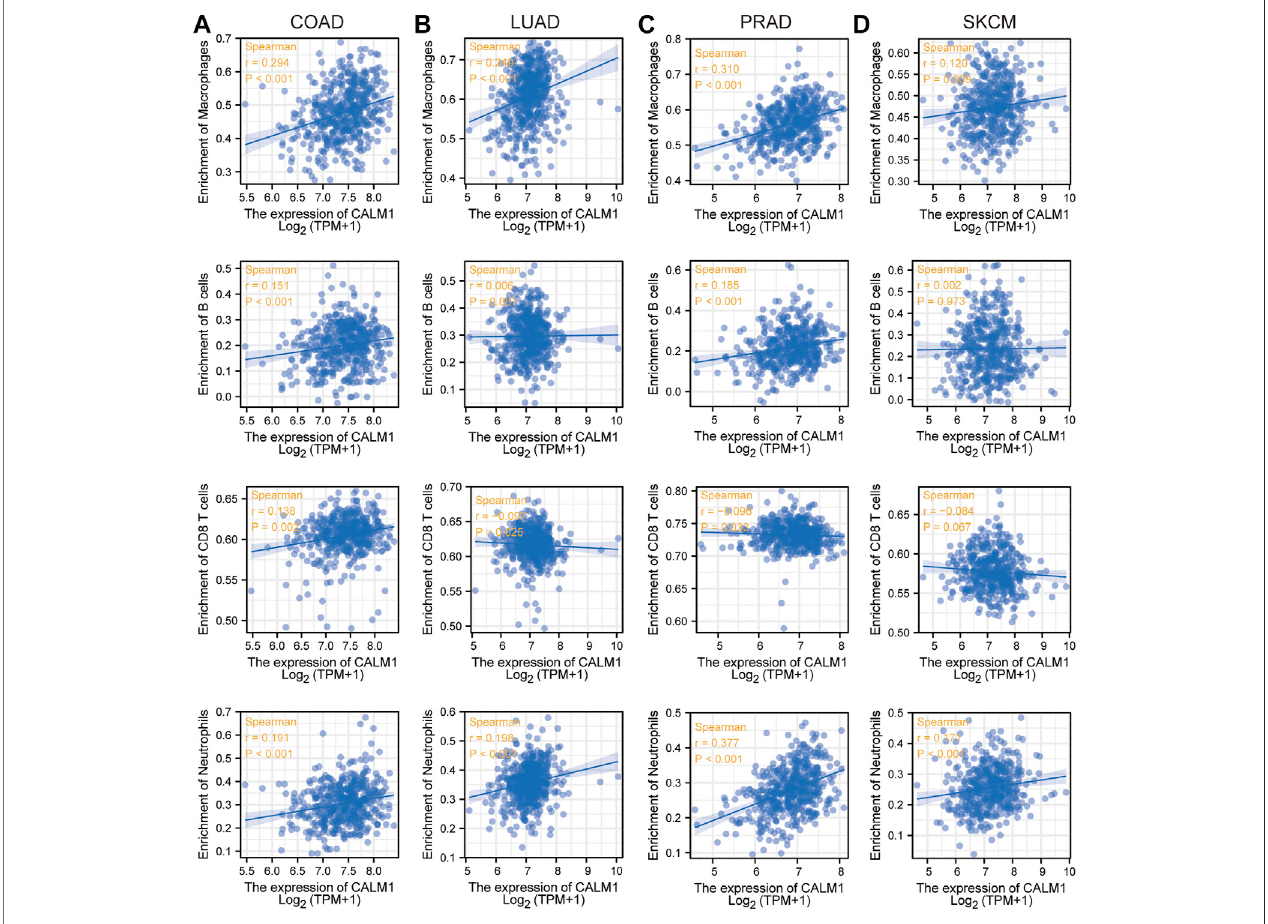
FIGURE4| Immune in fi ltration analysisof CALM1 expression. Correlationbetween CALM1 mRNAlevelsand immune in fi ltration incolonadenocarcinoma(COAD) (A) , lung adenocarcinoma (LUAD) (B) , prostate adenocarcinoma (PRAD) (C) , and skin cutaneous melanoma (SKCM) (D) .